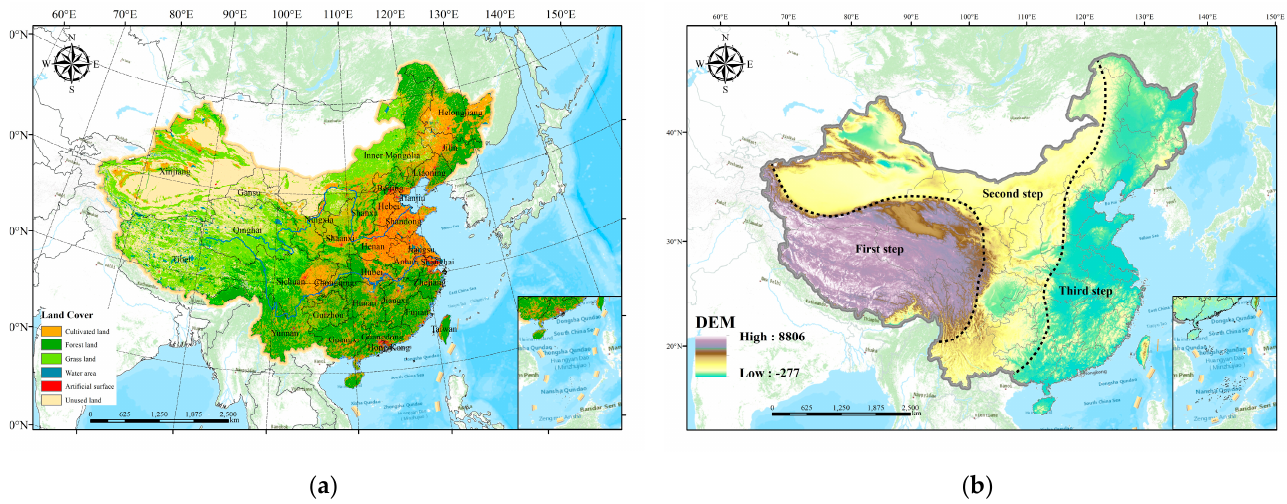
Figure 1. Land cover and topographic features of the study area. ( a ) Land use in China; ( b ) China’s topography.